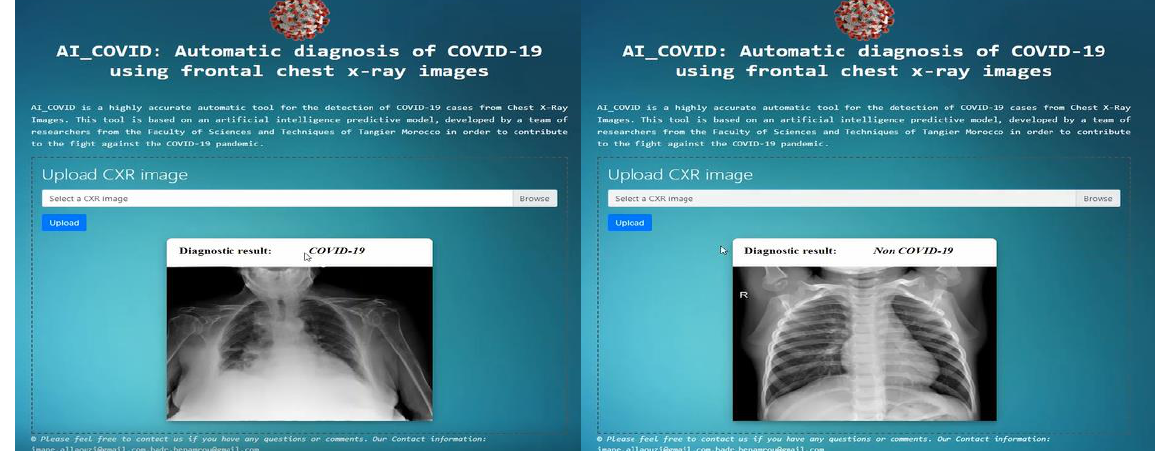
Figure 6. Example of two x-ray images diagnosed by the AI COVID